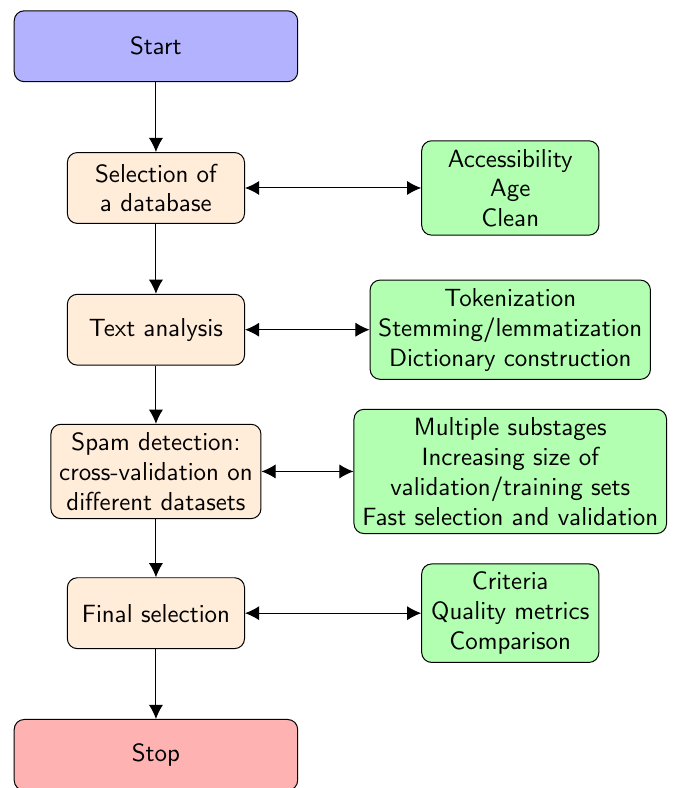
Figure 1. The proposed multistage meta-algorithm for performance check of the spam detection algorithms.